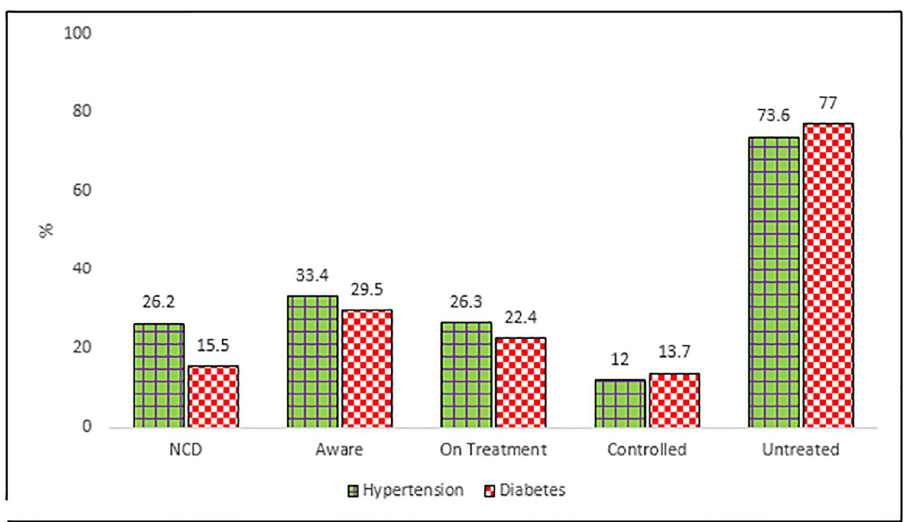
Fig 1. Status of hypertension and diabetes: Extent of awareness, treatment and controlled cases in Haryana, 2016– 2018.